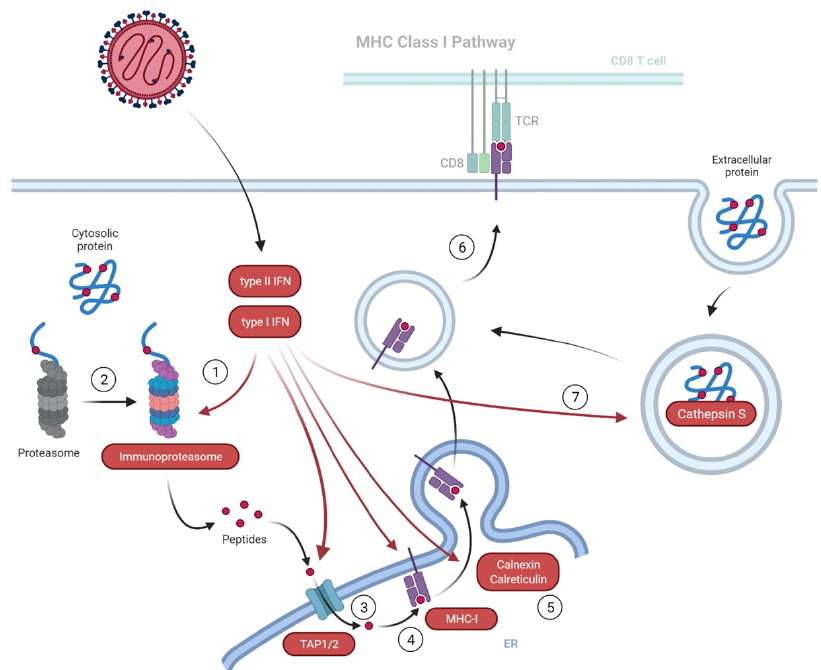
Figure 12. Model of type I/II IFN mediated upregulation of MHC I antigen presentation after NiV infection of PBEC-ALI cultures. Upon type I and type II interferon response (1), conventional protea- somes convert to immunoproteasomes (2). Simultaneously, upregulation of the TAP-heterodimer (3), MHC I subunits (4), and associated ER chaperons (5) indicate elevated peptide transport and MHC I antigen presentation (6). Elevated levels of endosomal protease cathepsin S (7) may lead to endosomal processing of extracellular antigens and cross-presentation through MHC I. Overall, in the bronchial epithelia, type I/II interferon responses may slow NiV replication and induce efficient processing of both intra- and extracellular antigens for priming of CD8+ T-cell mediated immune responses.